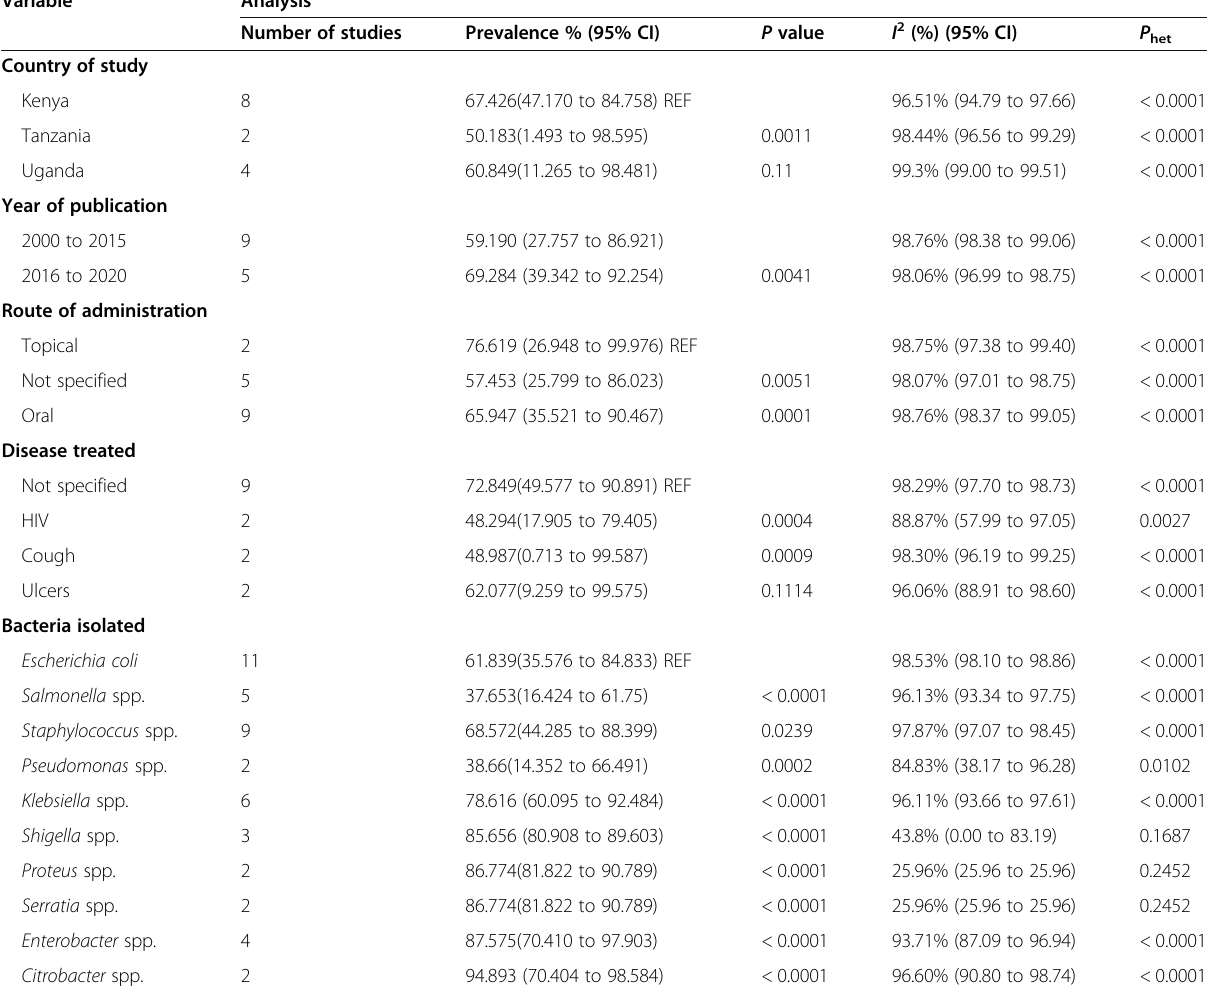
Table 4 Sub-group analysis of pooled prevalence estimation of bacterial contaminants in herbal medicines sold in E. Africa from